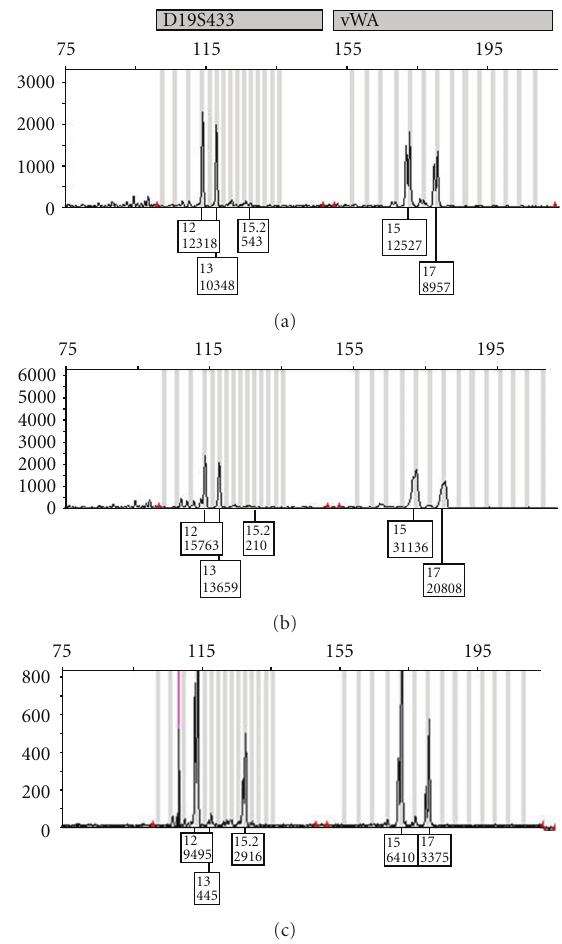
Figure 1: Chimerism analysis showing complete donor type in T-and non-T-cell lineages in the bone marrow (a, b) and mixed chimerism in the plasmacytoma